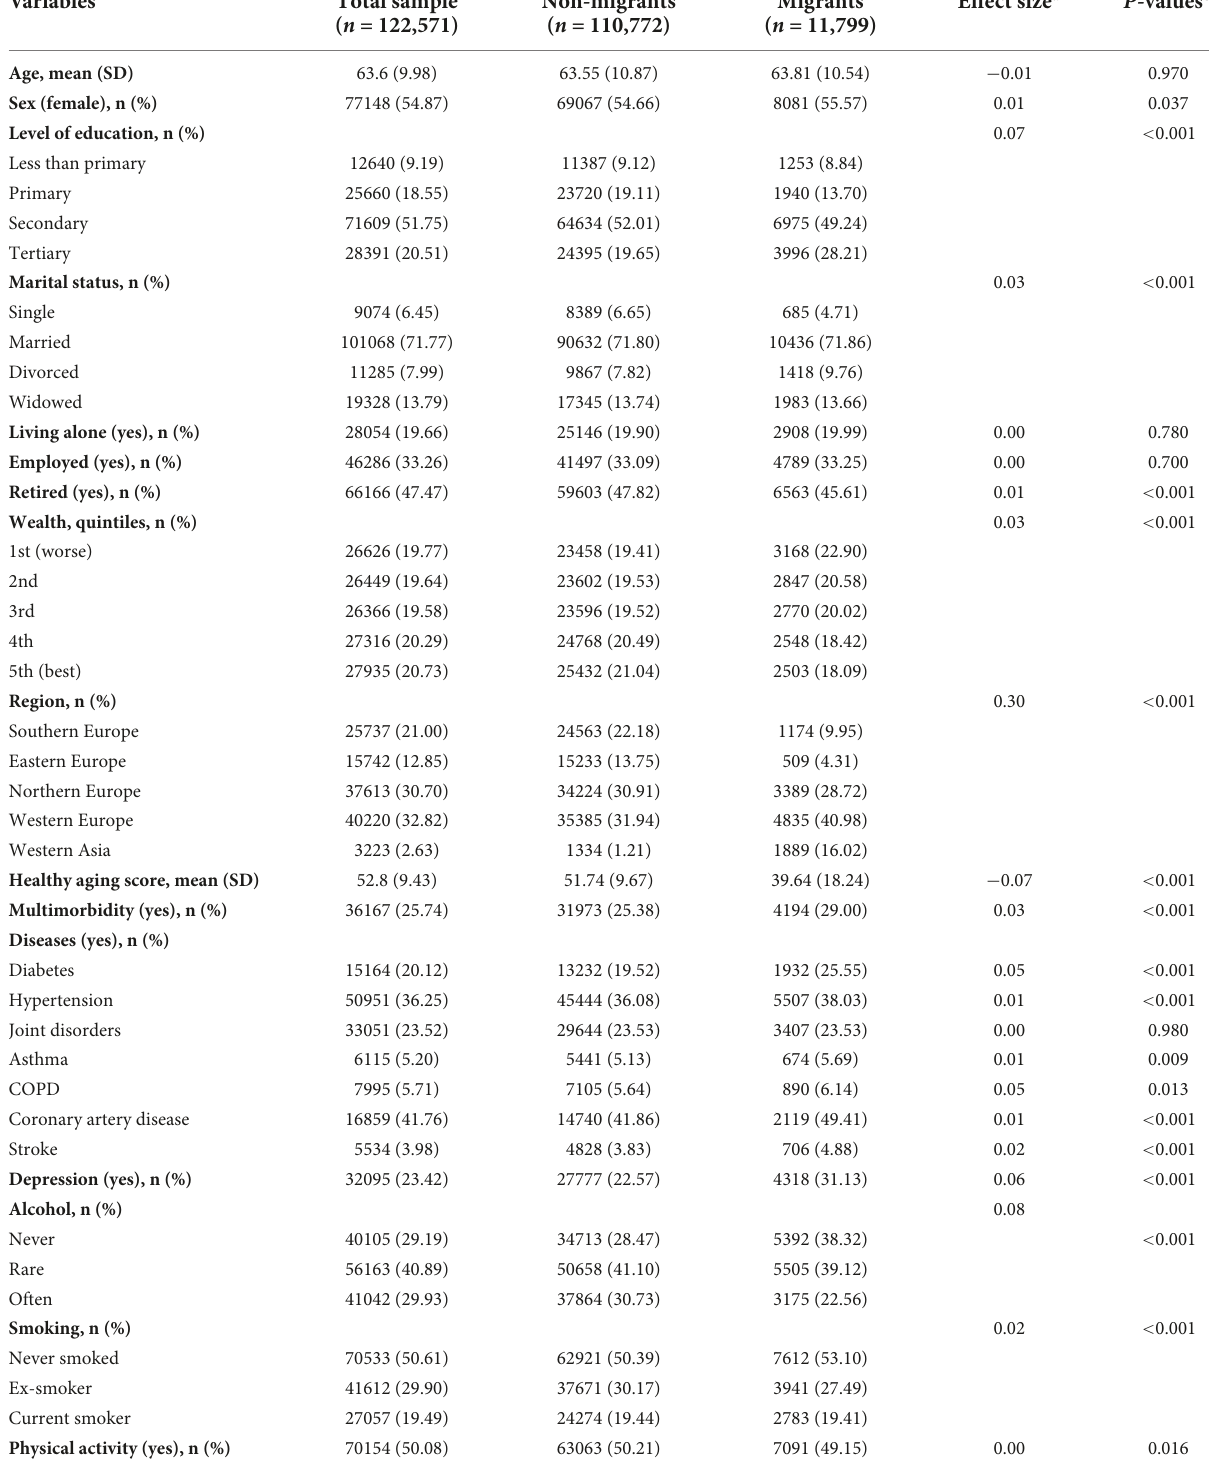
TABLE 1 Differences in socioeconomic status, healthy aging, multimorbidity, depression, and lifestyle behaviors between migrants and